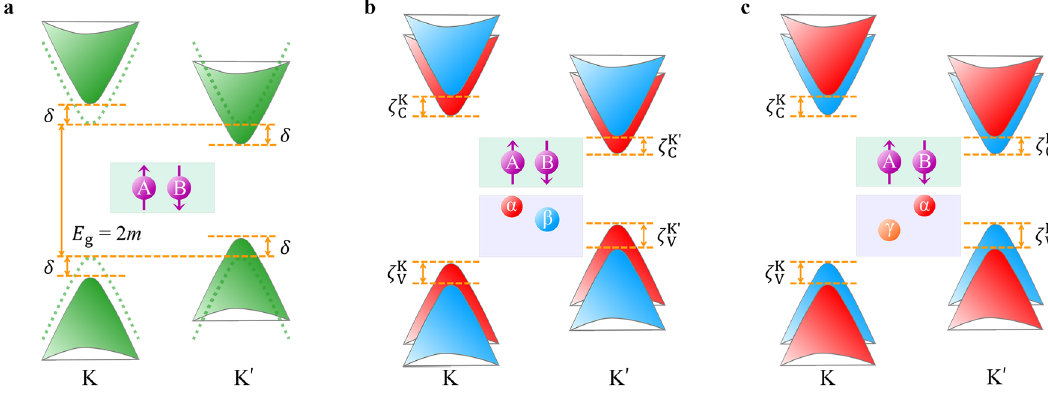
Fig. 1 Schematic band structures of monolayer MnPSe 3 . Schematic diagrams for the K and K ′ valleys of monolayer MnPSe 3 a without and b , c with nonuniform potentials on the A and B sublattices. Dotted and solid cones in a represent the valleys without and with considering SOC, respectively. Red and blue cones in b and c correspond to two spin states,